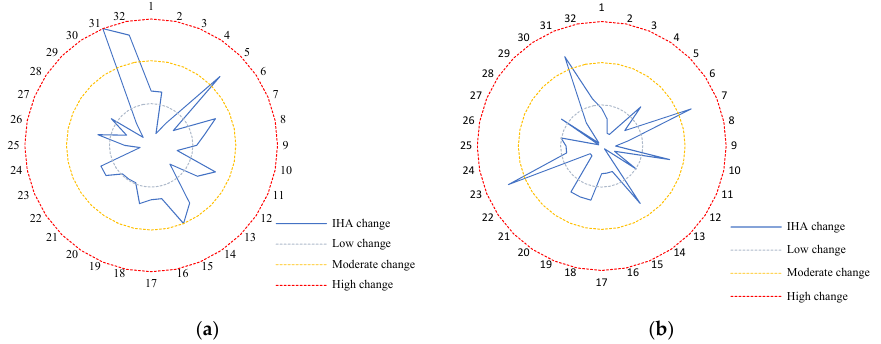
Figure 3. Schematic diagram of the hydrological change degree. ( a ) Schematic diagram of the hydrological change degree at the Gaochang station; ( b ) schematic diagram of the precipitation change degree in the Min River basin. Table 4. Overall Min River discharge and precipitation change degree.